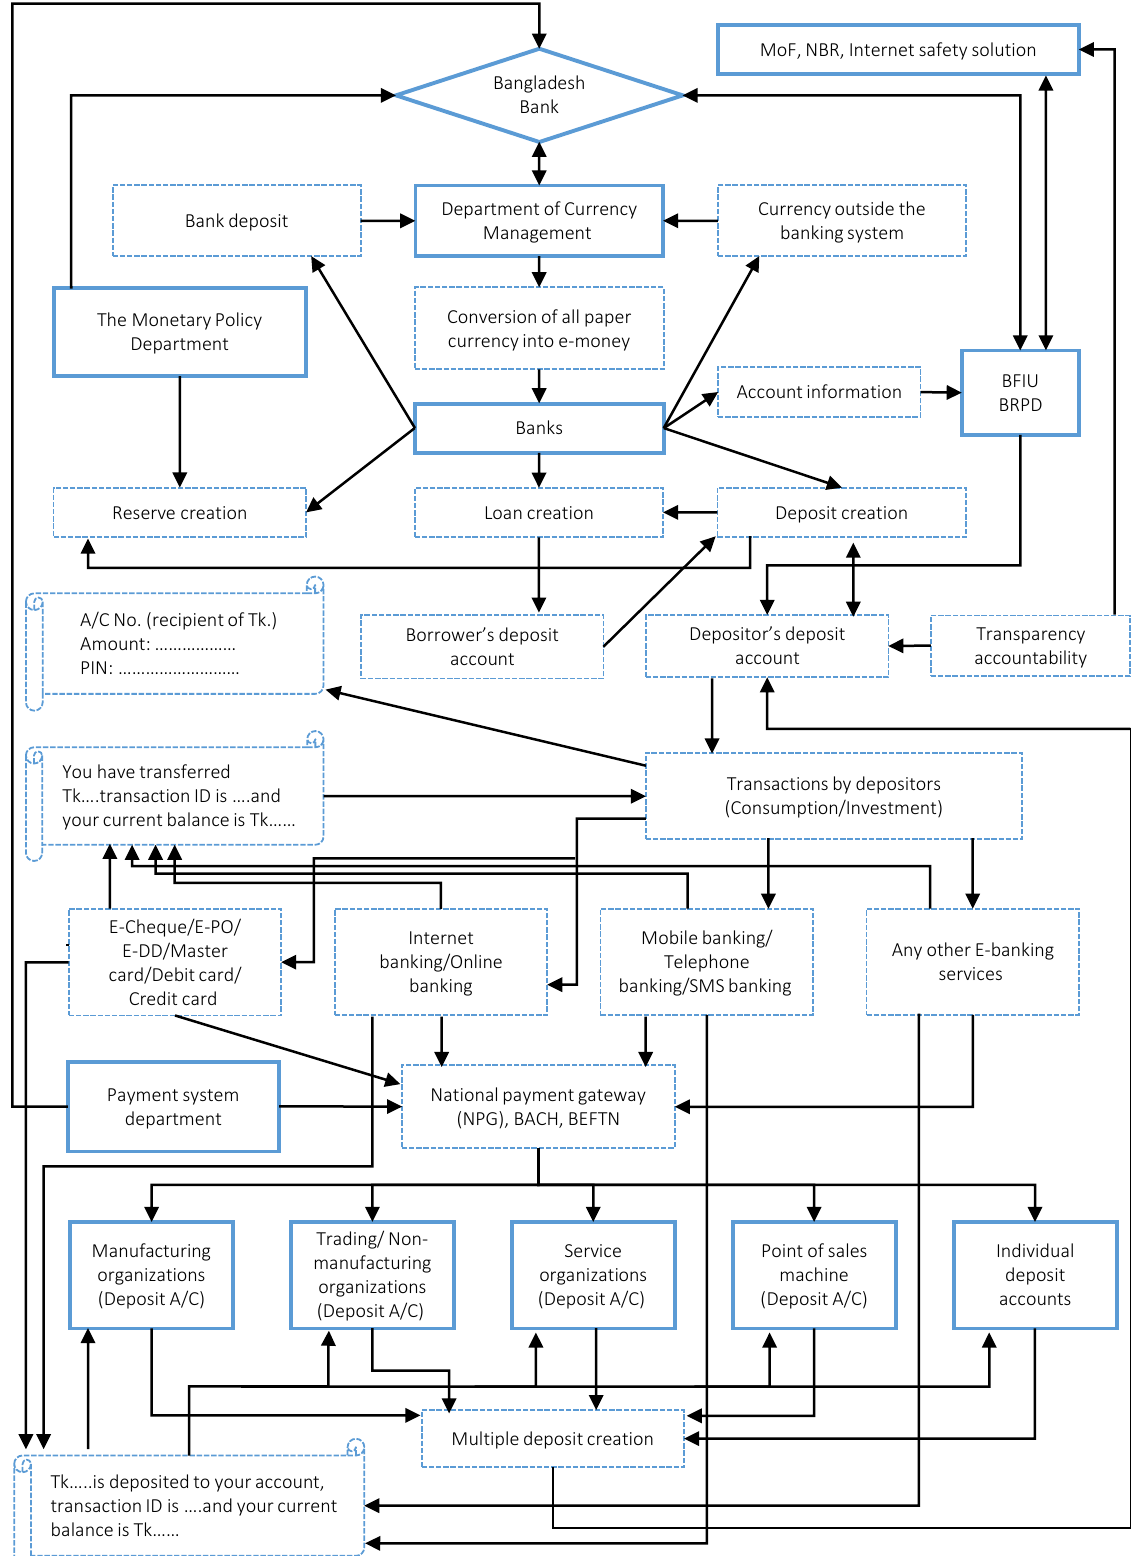
Figure 1. Operational